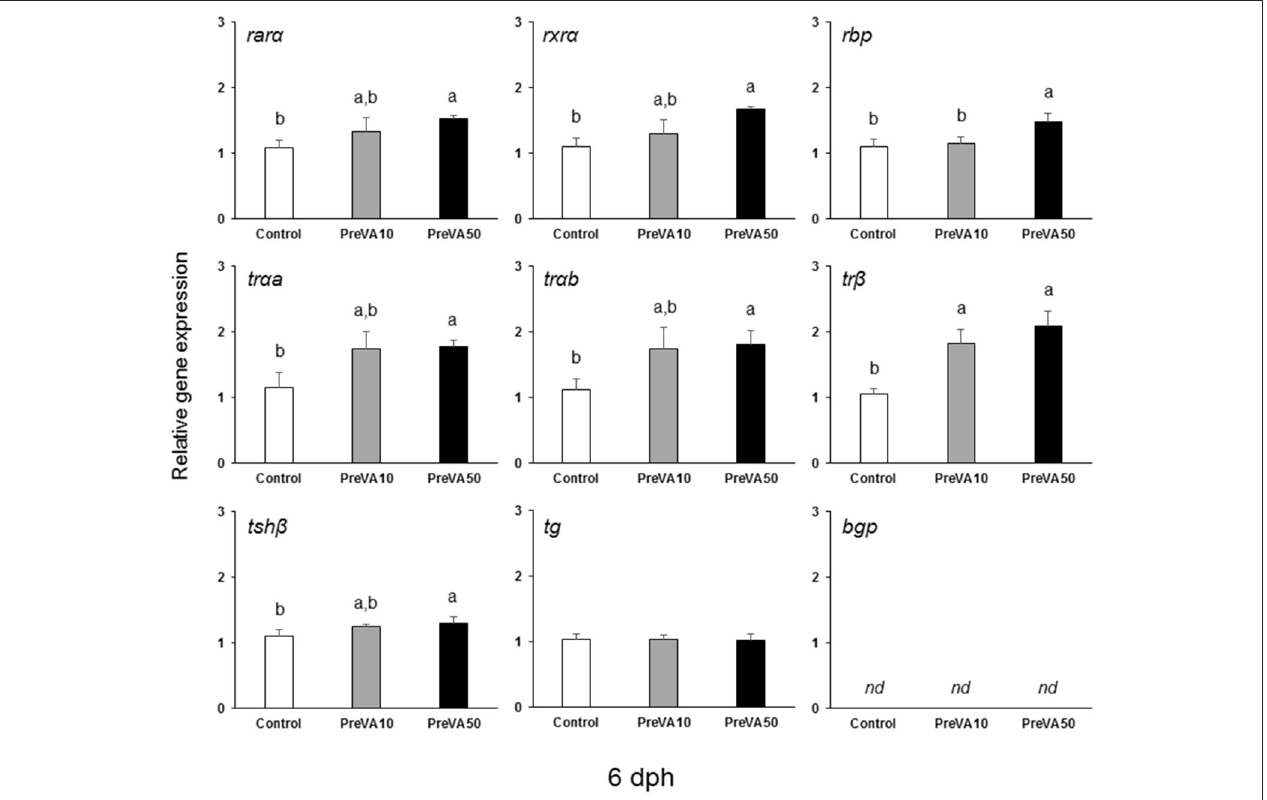
FIGURE 10 | Expression of selected genes related with vitamin A, thyroid hormone and extracellular matrix mineralization in Senegalese sole larvae at 6 dph when fed with increased dietary vitamin A levels during pre-metamorphosis. rar α , retinoic acid receptor α ; rxr α , retinoid x receptor α ; rbp, retinol binding protein; tr α a, thyroid hormone receptor α a; tr α b, thyroid hormone receptor α b; tr β , thyroid hormone receptor β ; tsh β , thyroid stimulating hormone β ; tg, thyroglobulin; bgp, bone gla protein . For a detailed description about the different experimental groups, please see the legend of Figure 1 . Different letters at the top of each bar denotes statistically significant differences among experimental groups (ANOVA, P < 0.05; N =